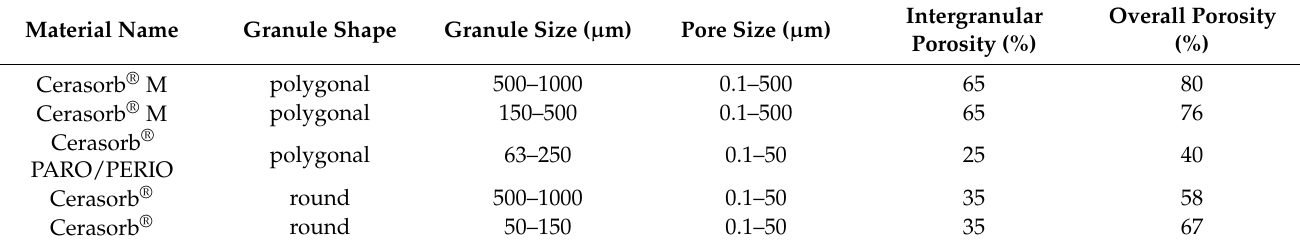
Table 4. Physical characteristics of the β -TCP-based bone substitutes samples. The overall porosity of the granules is the sum of intragranular porosity (measured by Hg-porosimetry) and intergranular voids. It is calculated from the crystal density of β -TCP and the measured bulk density.